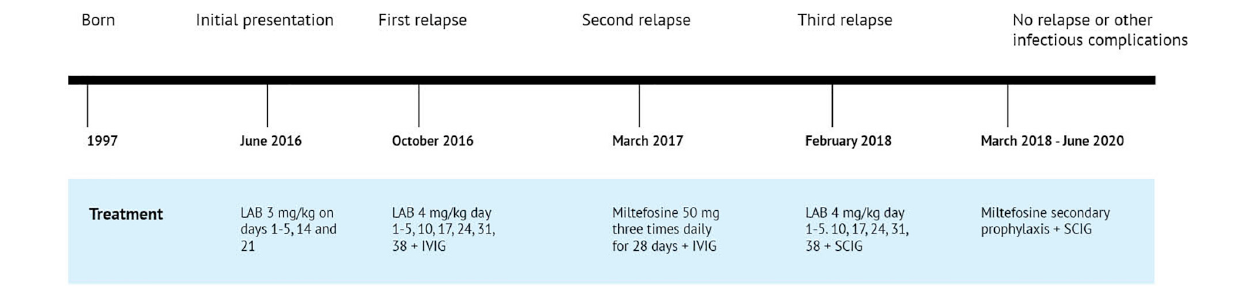
After completion of the treatment for the third relapse, secondary Leishmania prophylaxis with Miltefosine was initiated. The initially dose was 50 mg per day, which was reduced to 50 mg three times per week, and finally to the current dose of 50 mg once weekly. The patient continues to receive immunoglobulin substitution, currently subcutaneous immunoglobulin (SCIG). As of June 2020, 2 years after the third relapse, no further relapses or other infectious episodes had